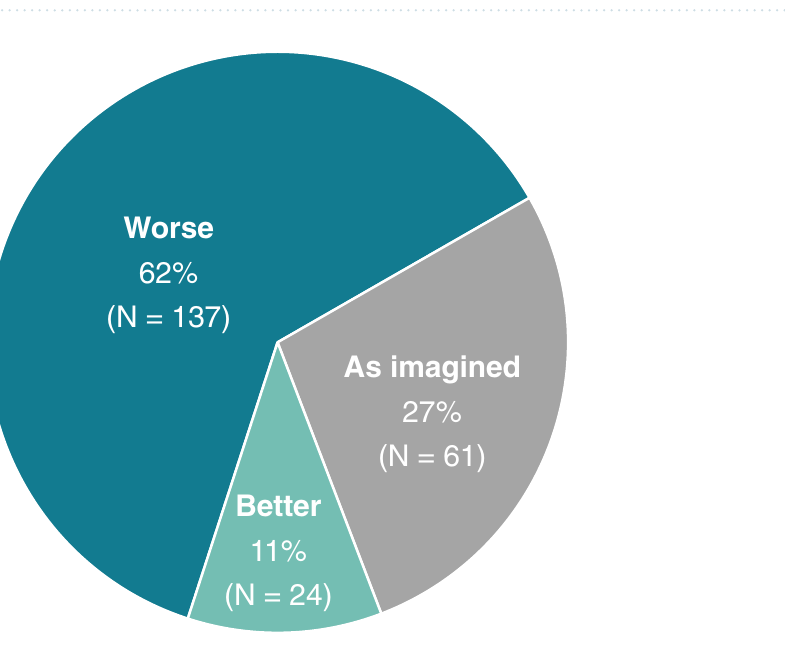
Figure 2. Mental health problems in relation to the PhD training. Participants were asked whether they think that their current mental health problems are related to their PhD training.